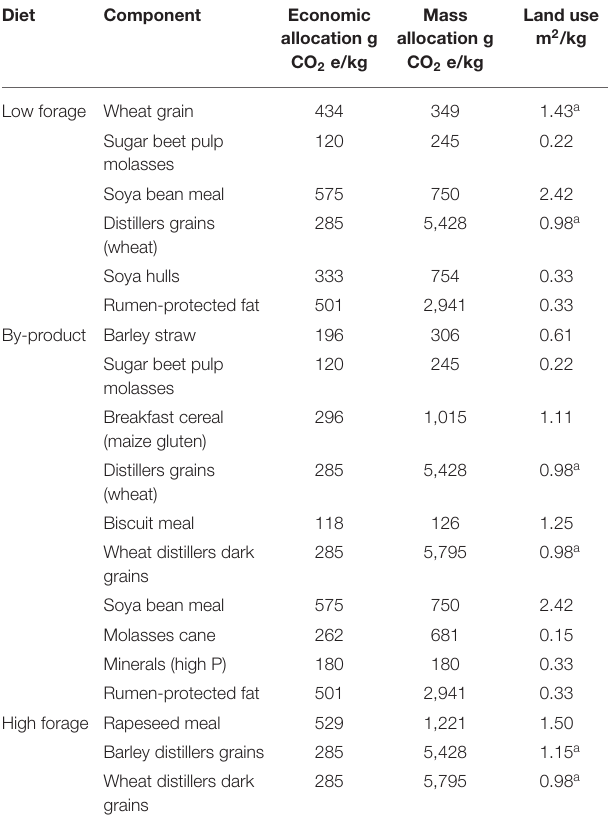
TABLE 2 | Average annual production characteristics for high production select merit cows. Low forage By-product High forage Home grown